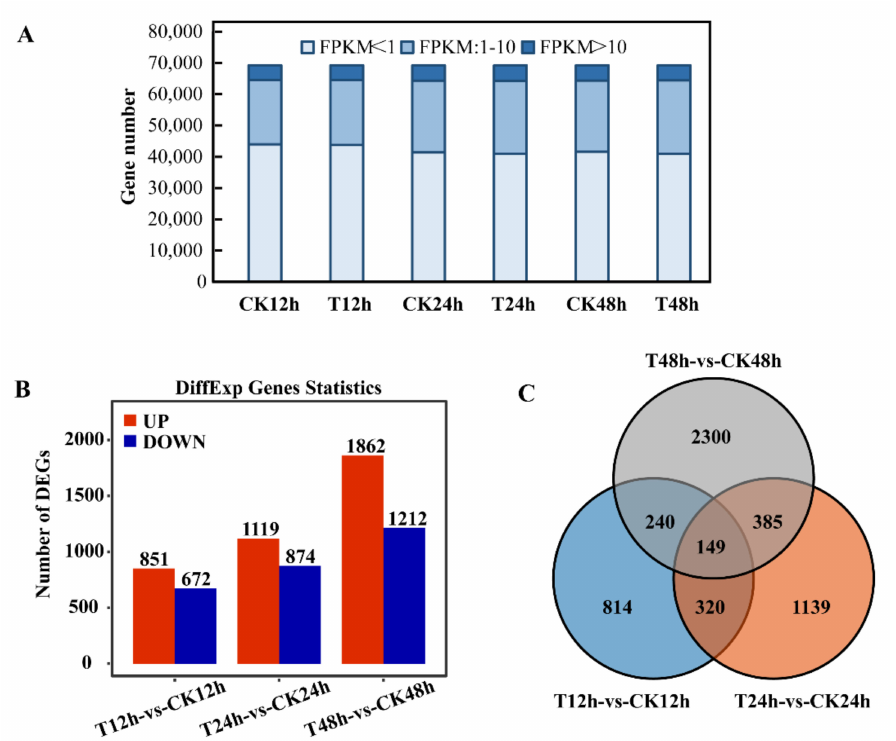
Figure 4. RNA-Seq statistics of 1 (cid:48) ,4 (cid:48) - trans -diol-ABA and control leaves during three time points (12h, 24h, and 48h) after treatment. ( A ) Stacked bar chart of the number of transcripts in different FPKM value ranges in the sample; Bar plot ( B ) and Venn diagram ( C ) Illustrating the number of DEGs compared with the control at 12 h, 24 h, and 48 h after treatment. The statistical standard of DEGs was the FDR < 0.05, log 2 (fold change) > 0.5 was up and log 2 (fold change) < − 0.5 was down. (T: 1 (cid:48) ,4 (cid:48) - trans -diol-ABA treatment, CK: